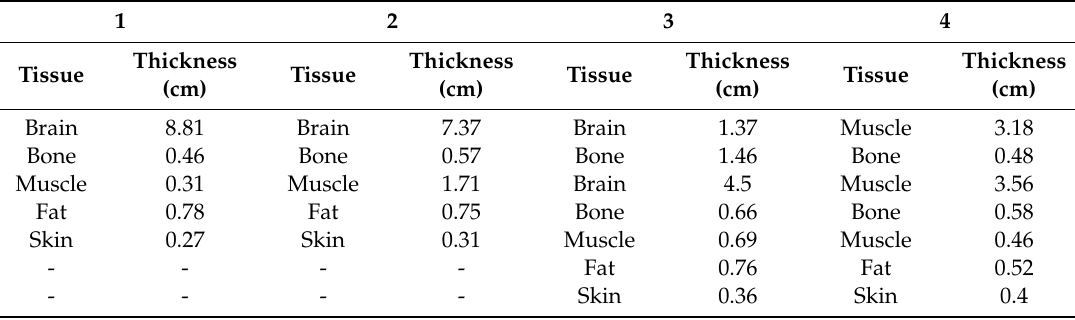
Table 2. Structure and tissue thickness of di ff erent sections along the red markers in Figure